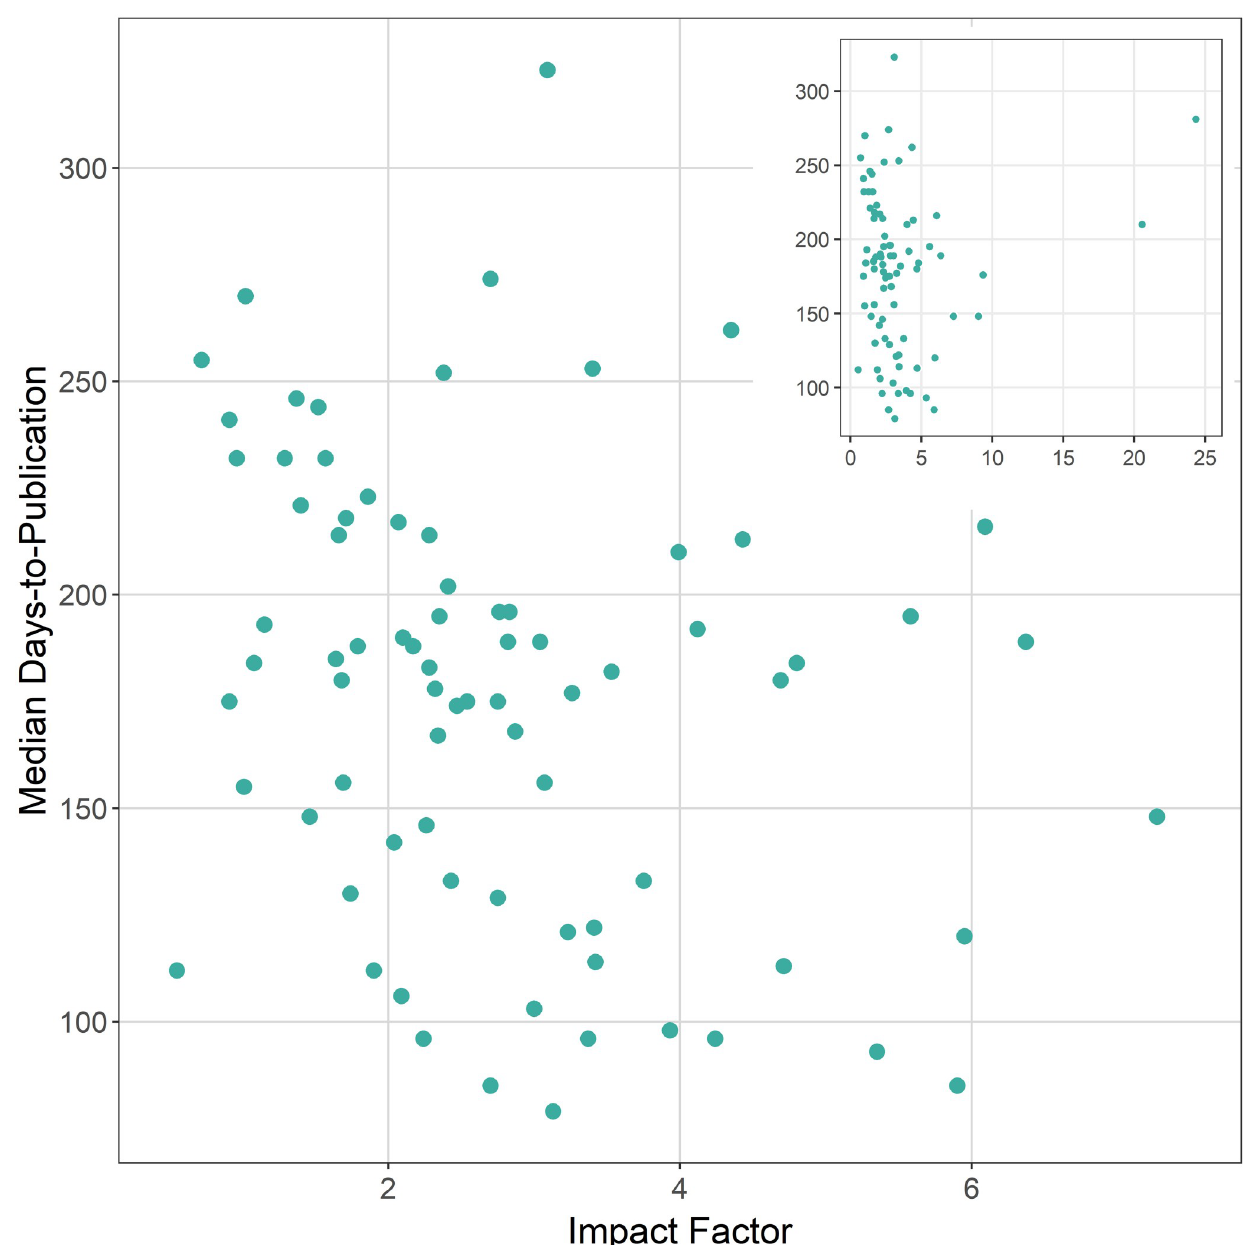
Fig 6. Median time-to-publication (d) versus 2018 impact factor for 82 journals that publish in fisheries and related topics. Inset panels shows a broader view to include Science and Nature which have high impact factors.